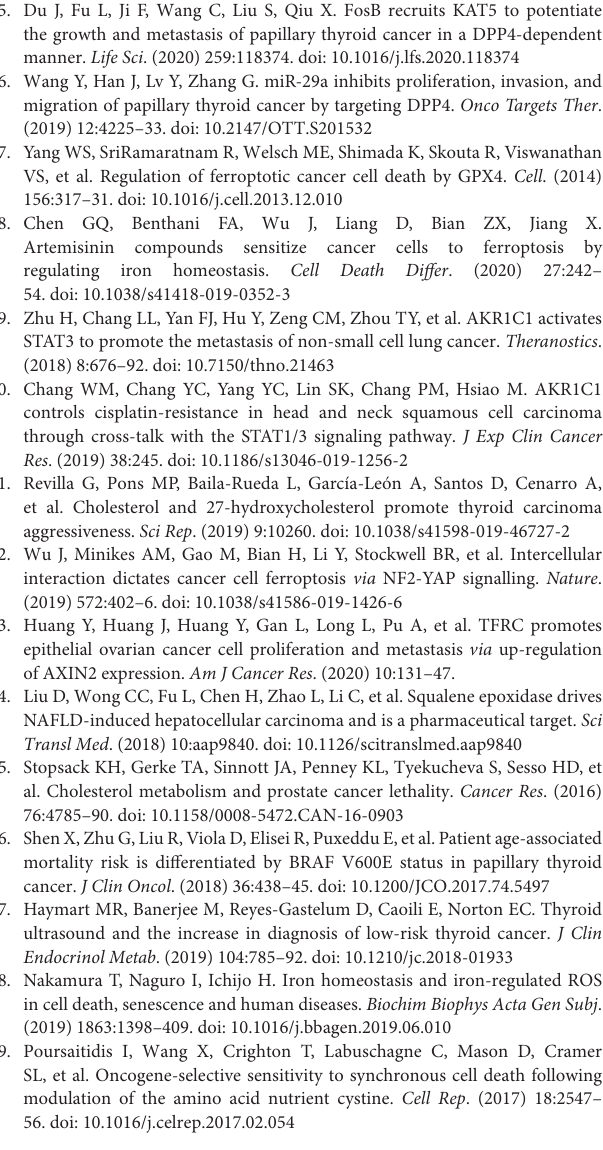
Supplementary Table 1 | A list of 60 ferroptosis-related